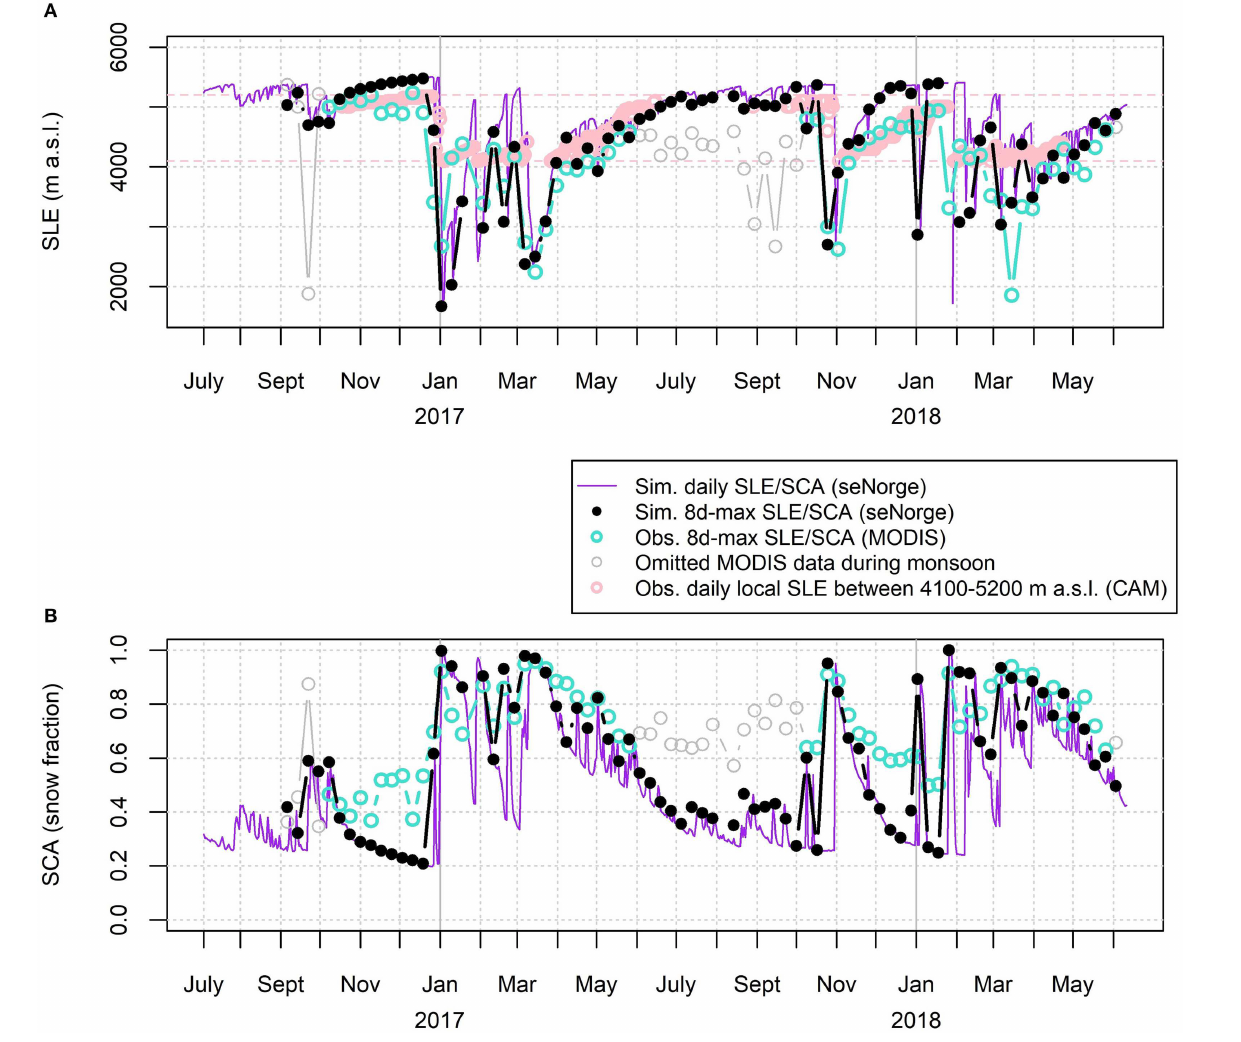
FIGURE 6 | Time series of observed and simulated (A) snow line elevation (SLE) and (B) fraction of snow-covered area (SCA) in the Langtang catchment. Observations are based on MODIS 8-day maximum values (light blue circles), and the omitted dubious monsoon data in June-September is indicated by gray circles. The locally observed SLE on the north mountain face seen by the time-lapse camera (CAM; Figure 1 ) is shown in (A) by pink circles and the detectable SLE value range 4,100–5,200m a.s.l. by horizontal pink dashed lines. Both daily (at 06:00 am, purple line) and 8-day-max (black circles) values of the model-simulated SCA and SLE are